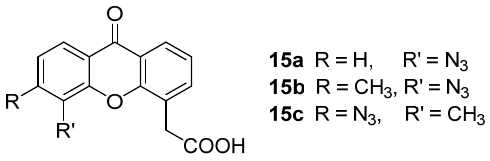
Figure 10. DMXAA analogues as photoaffinity labels.